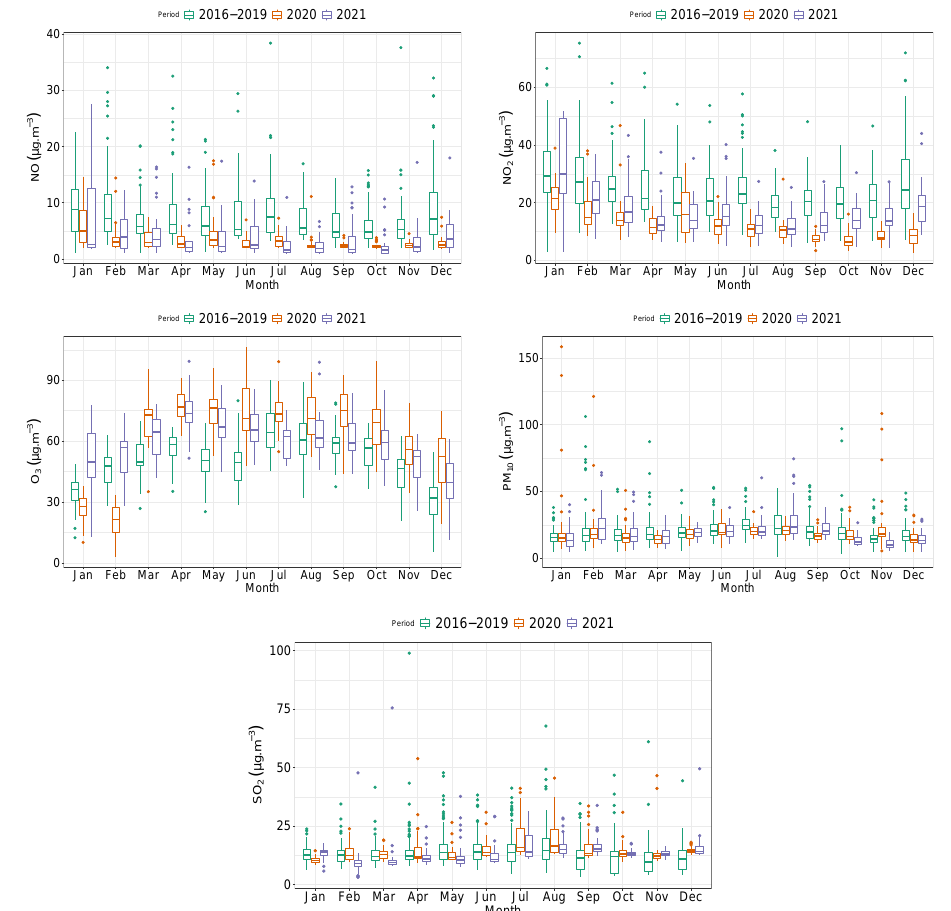
Figure 8. Box and whiskers plots of the daily concentrations of NO, NO 2 , O 3 , PM 10 , and SO 2 at the Valle station. The bottom and top of the box represent the first and the third quartiles, respectively; the horizontal line in the box represents the median; dots are the outliers; whiskers are the lowest and highest values, excluding the